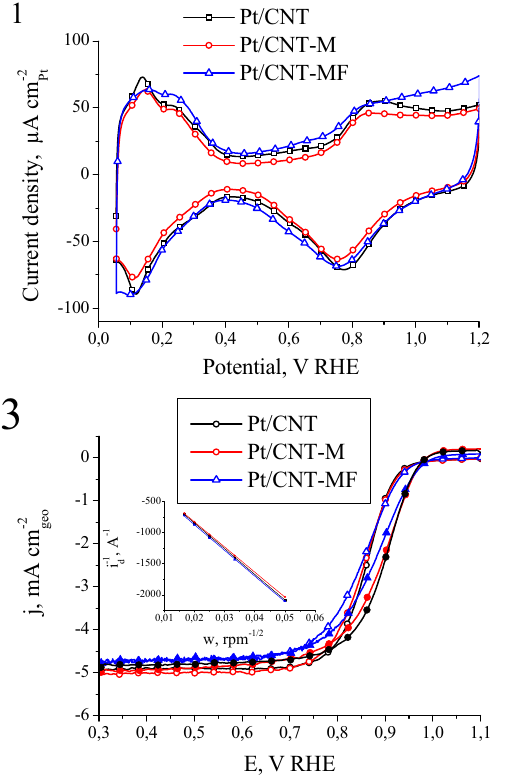
Fig. 5 1 CV curves of the Pt/C catalysts, scan rate—0.05 V s −1 ; 2 CV curves of CO monolayer electrooxidation, scan rate—0.05 V s −1 ; 3 ORR curves for Pt/C catalysts at 0.9 V, rotating rate—1600 rpm, scan rate—0.01 V s −1 , anode scan—closed symbols, cathode scan—